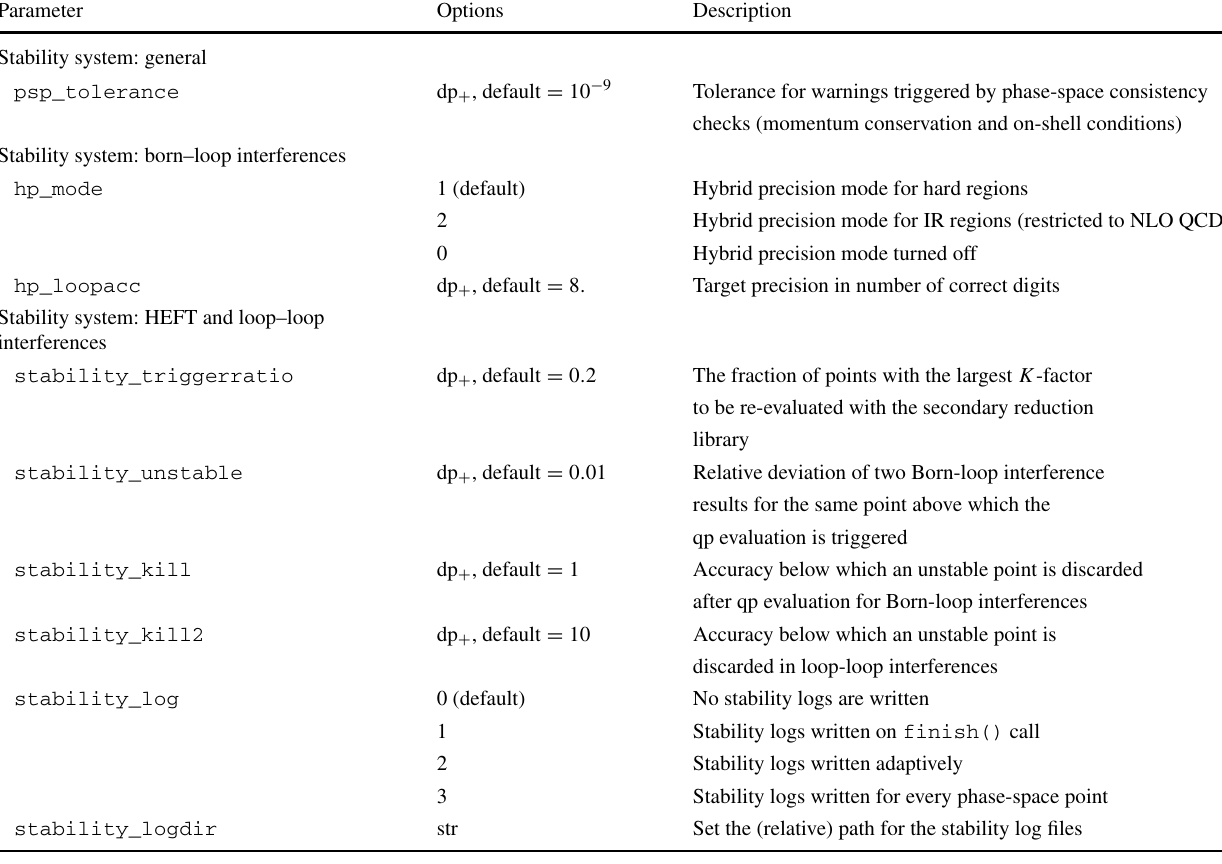
Table 11 Available input parameters and switches in OpenLoops relevant for the stability system. Possible inputs include dp + : positive double, int: integer, str: string. For details see Sect.